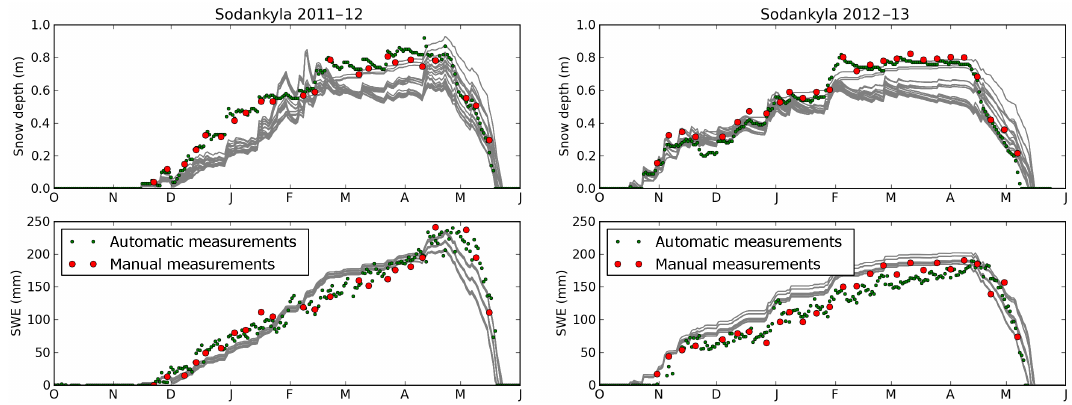
Figure 3. Snow depth and water equivalent simulated by the Jules Investigation Model subset used in this study. Grey lines indicate individual JIM subset member simulations. Note that erroneous positive SWE observation points have been removed at the end of the season when snow depth is zero, as this is a sensor artifact related to soil moisture